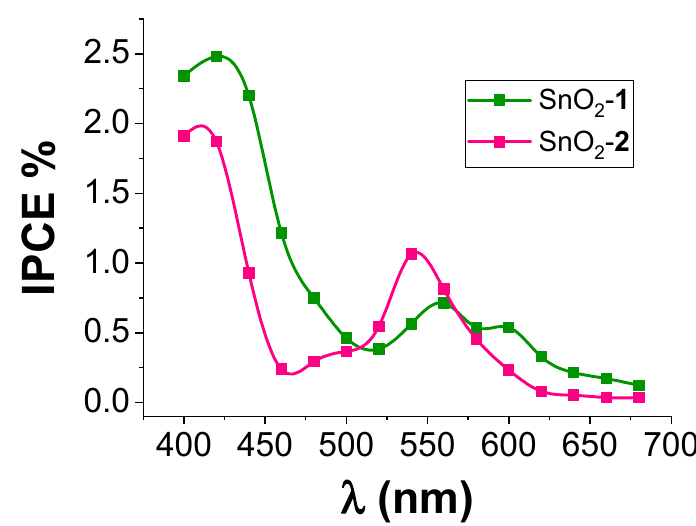
Figure 9. IPCE spectra of SnO 2 - 1 and SnO 2 - 2 photoanodes recorded in 0.1 M HBr (pH 1) under 0.6 V versus SCE applied bias. Illumination was through the ohmic contact (FTO).